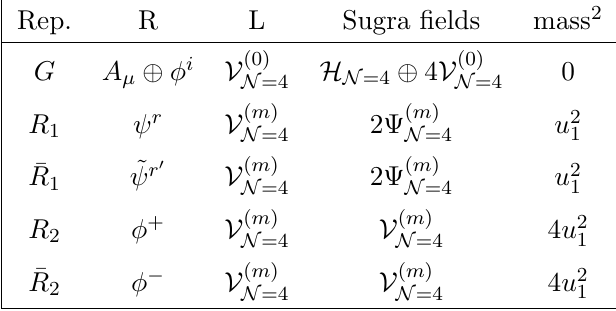
Table 4 . Fields and mass spectra for the gauging of N = 8 supergravity with N = 4 residual supersymmetry. The spectrum and unbroken gauge symmetry in the ground state correspond to the CSO (cid:3) (4 ; 4) with noncompact gauge group SO (cid:3) (4) and maximal compact subgroup SU(2) (cid:2) U(1) in the notation of